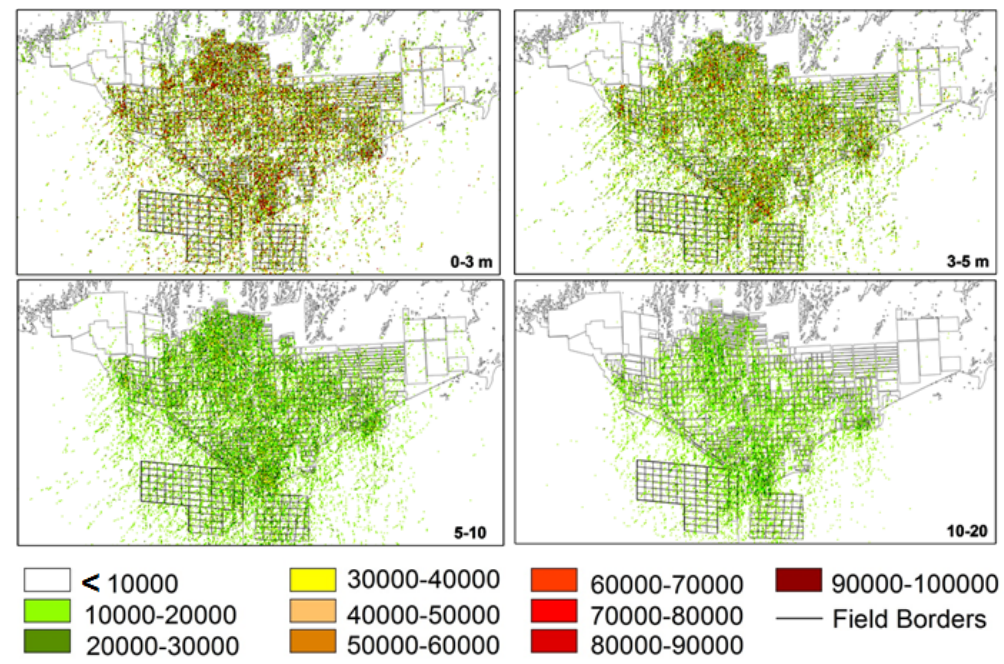
Figure 7. Results of NO concentrations (ngm − 3 ; in terms of mass of nitric oxide) calculated by the LASAT dispersion model for the first four vertical levels on 9 June, 2011, 11:30 to